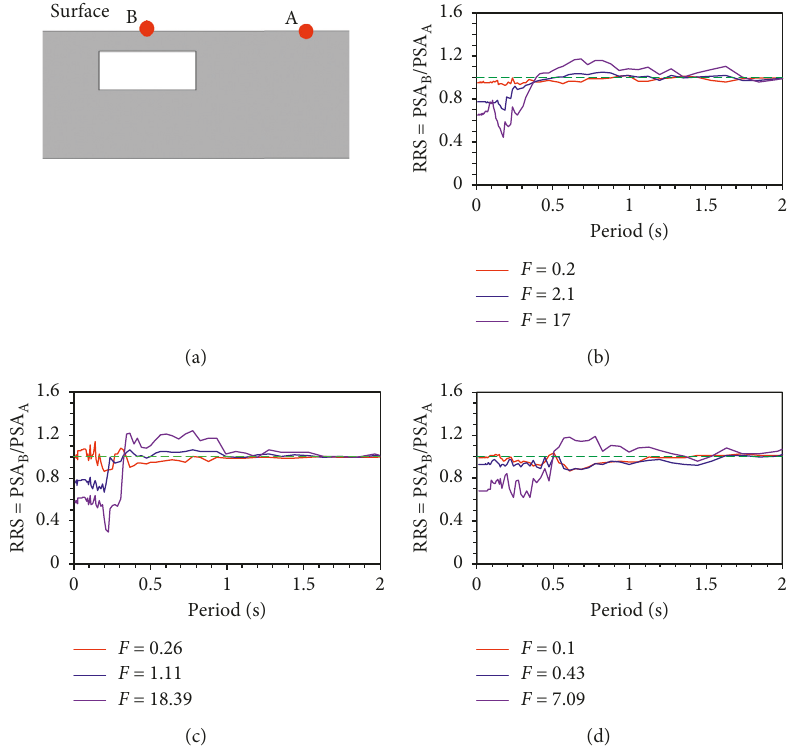
Figure 13: Surface RRS (a) comparison for various F ratios for (b) Loma Prieta, (c) Nahanni, and (d) Chi-Chi